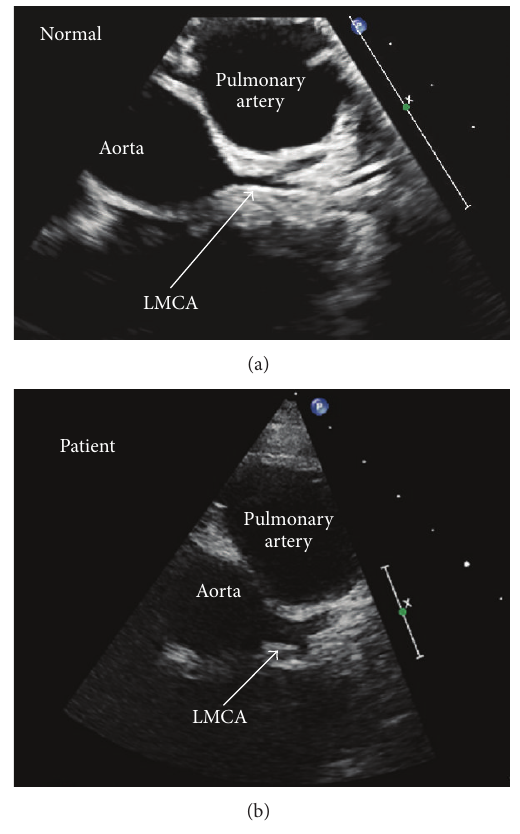
Figure 2: Parasternal short axis view showing dilated LMCA of our patient with normal shown for